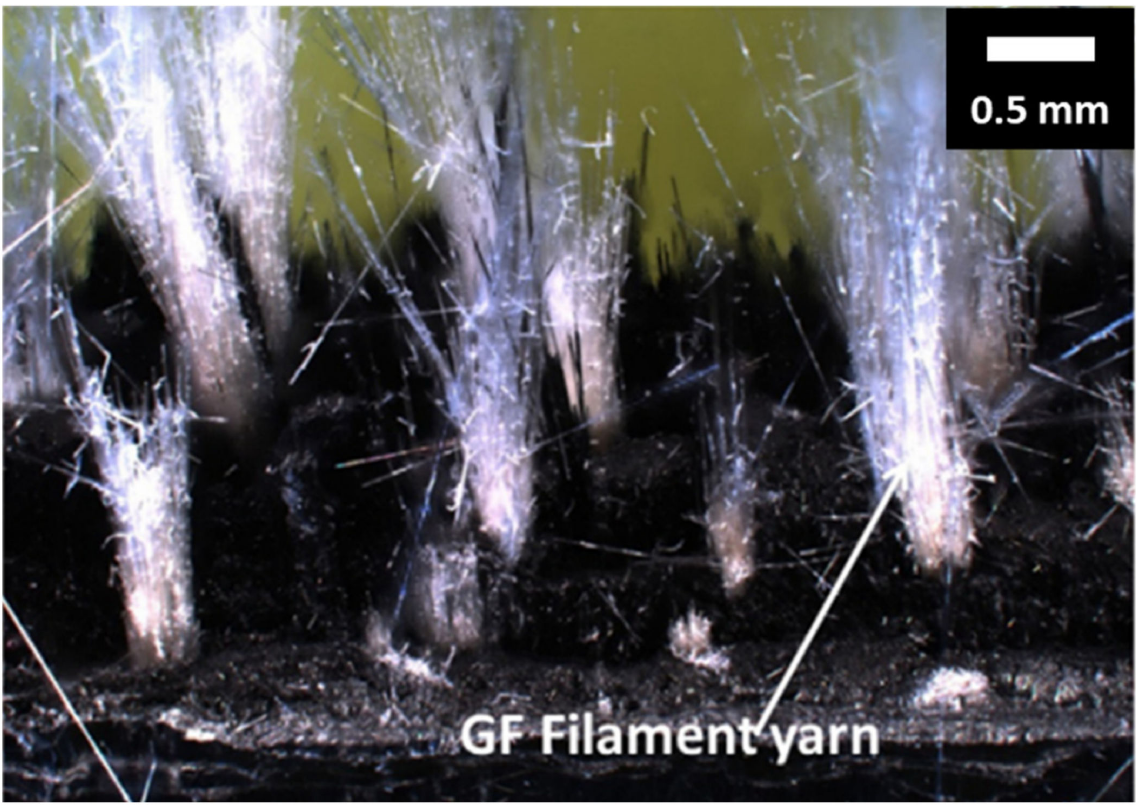
Figure 17. Image of hybrid staple carbon fiber/glass fiber filament/PA6 Charpy impact test specimen failure surface. Reprinted with permission from [84]. Copyright 2019